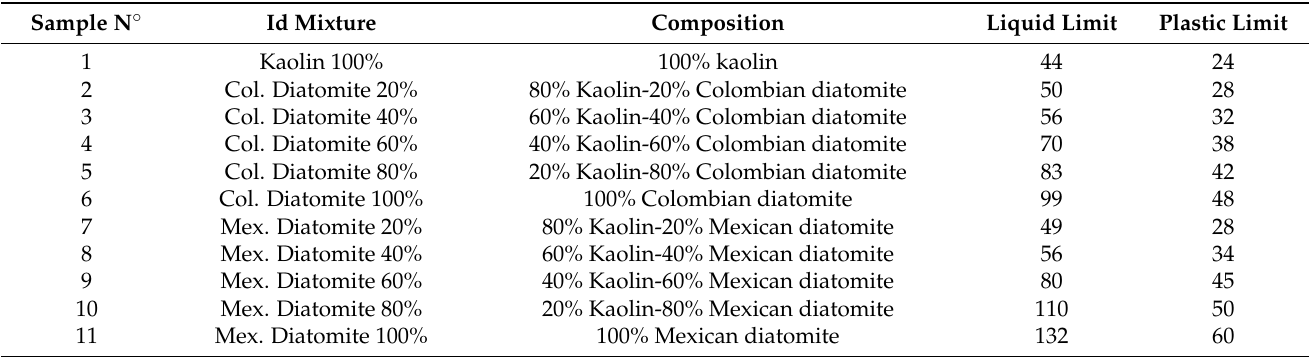
Table 1. Mass ratio in percentage of the mixture